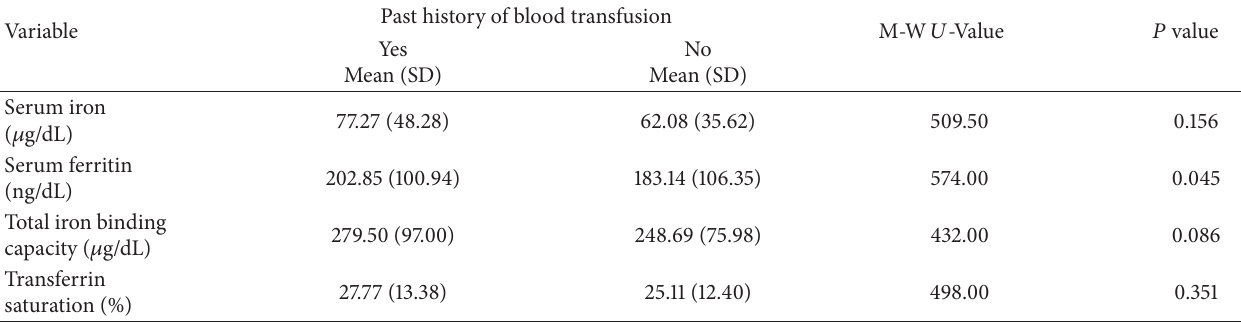
Table 3: Serum iron, serum ferritin, total iron binding capacity, and transferrin saturation profile of sickle cell anaemia subjects according to history of blood transfusion.